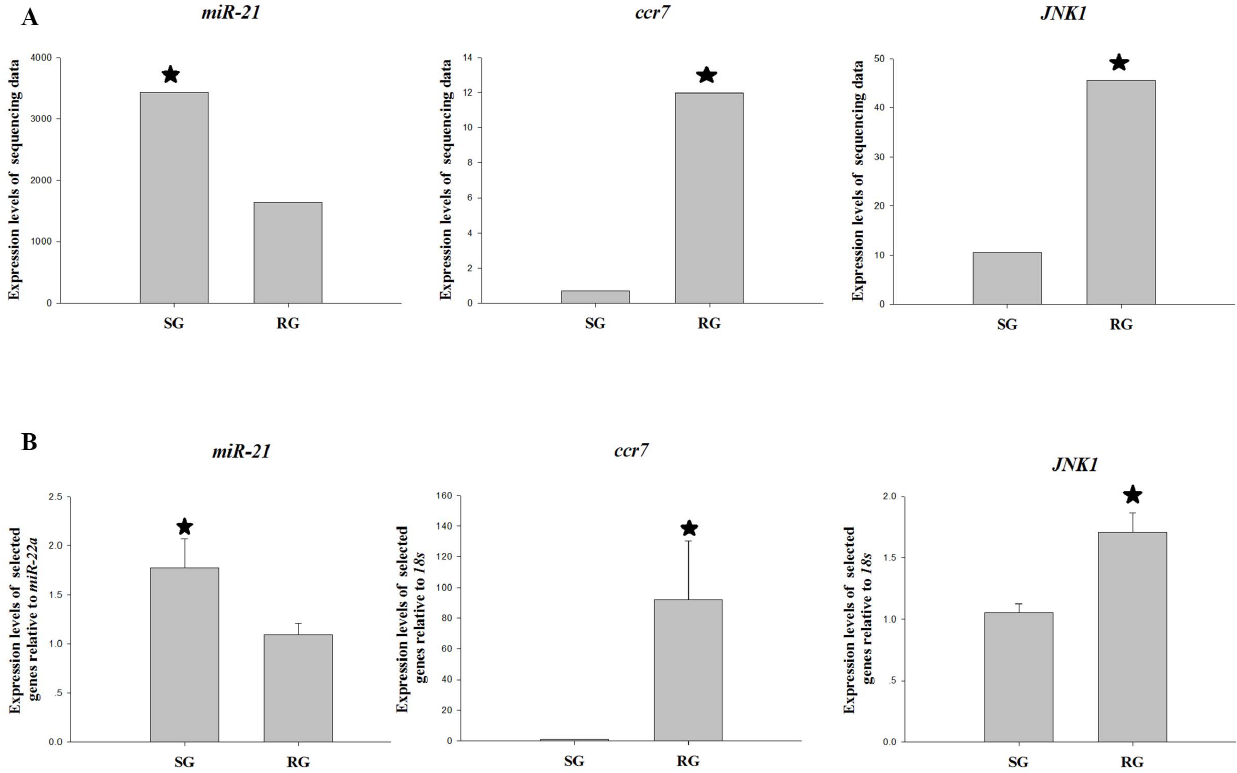
Figure 4. The expression analysis of selected genes from the expression profile by relative quantitative real-time PCR. A Transcriptome sequencing data, B Real-time PCR data. Increases and decreases in relative levels of transcripts with respect to the control 18s for mRNA and miR-22a for miRNA are shown. The settings ‘‘q.value , 0.005’’ and ‘‘|log2.Fold change.normalized| . 2’’ were used as thresholds for judging significant differences in transcript expression. One-way ANOVA tests were performed using SPSS 17.0 to determine significant differences for Real- time PCR data. Statistical significance of the relative expression ratio is indicated *.